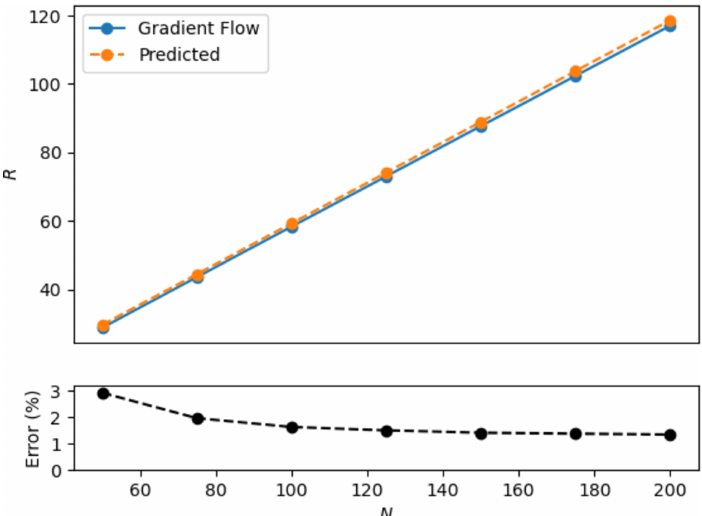
Figure 10 . A comparison of the predicted radii from the TSA to the radii of solutions found via gradient flow with model parameters η with Q/N = 14 . 98 kept constant.